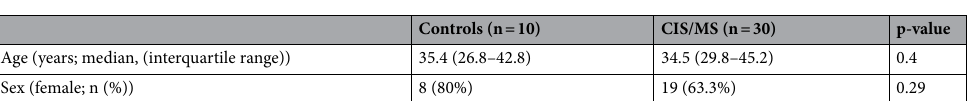
Table 1. Demographic details of controls and patients with clinically isolated syndrome (CIS) or multiple sclerosis (MS). Statistical comparisons were made using a Mann–Whitney test for age and Fisher’s exact test for